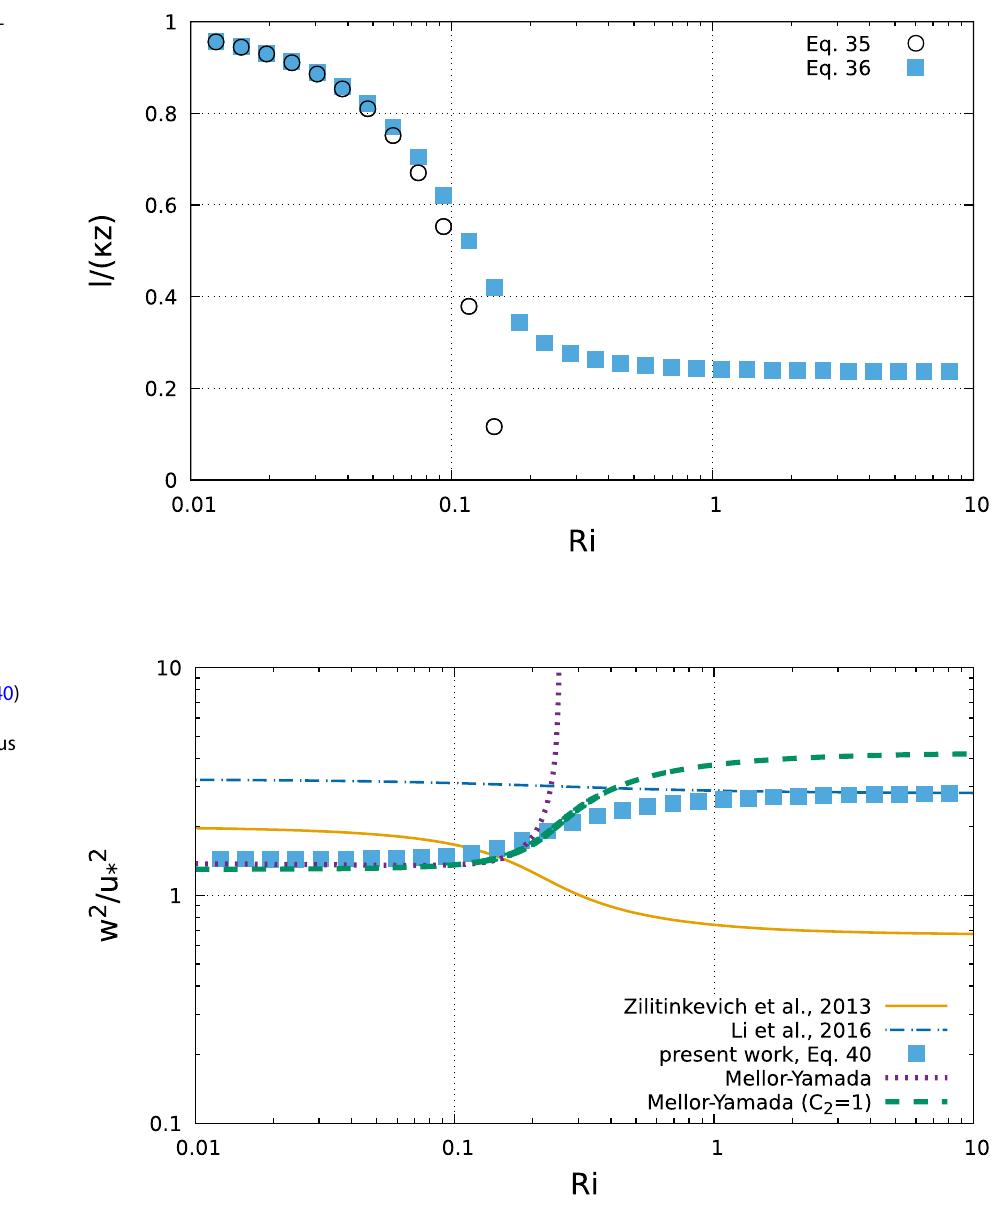
Fig. 4 Blue squares: vertical velocity variance from Eq. (40) as function of Ri . Coloured lines: expression from various